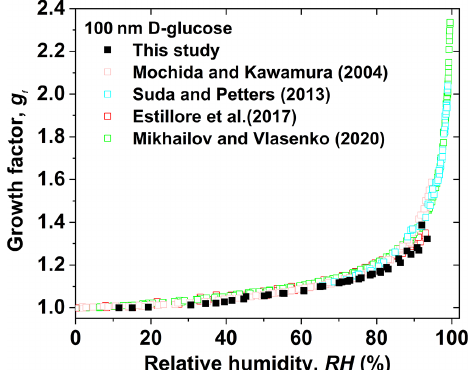
Figure 7. Hygroscopic diameter growth factor ( G f ) of D-glucose particles with a dry diameter of 100nm in both deliquescence and efflorescence modes (black solid square). The measured data com- pared with reference data from Mochida and Kawmura (2004) in both deliquescence and efflorescence modes (pink open square), Suda and Petters (20017) in deliquescence mode (violet open square), Estillore et al. (2017) in both deliquescence and efflores- cence modes (red open square), and Mikhailov and Vlasenko (2020) in both deliquescence and efflorescence modes (green open